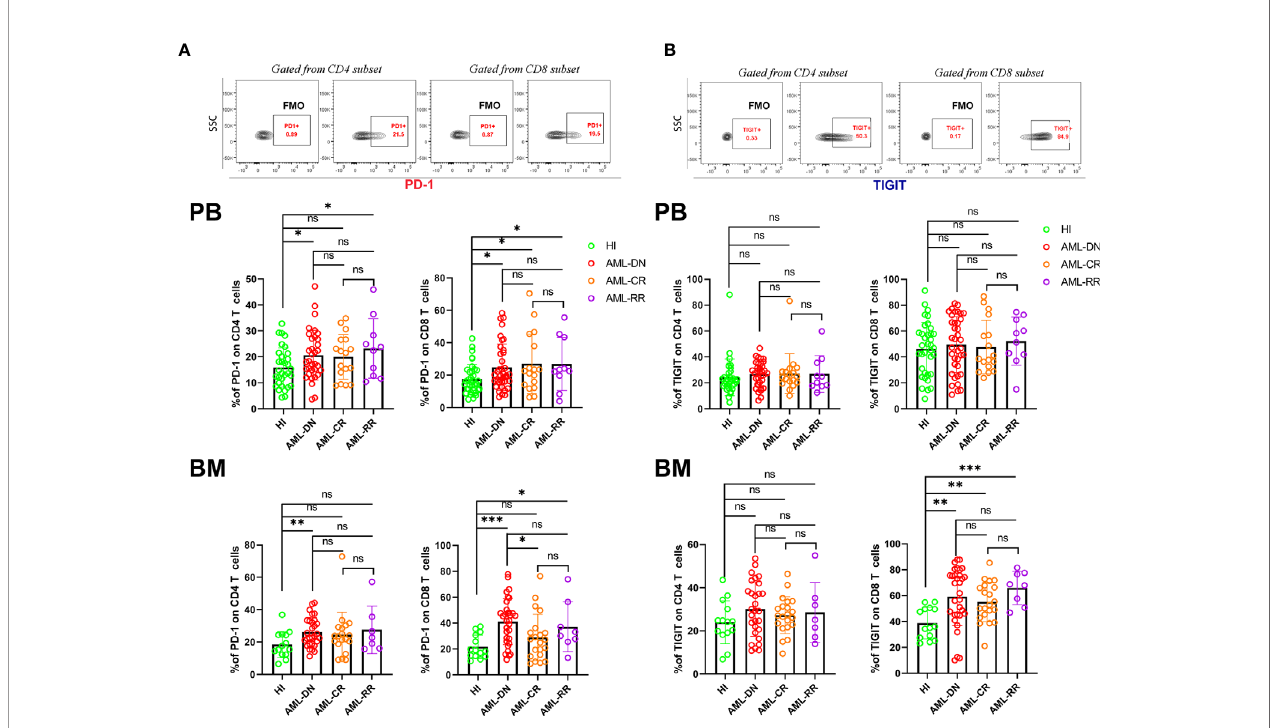
FIGURE 1 | T cells from the PB and BM of DN AML and R/R AML patients generally have high expression of PD-1, and BM CD8 + T cells from DN, CR, and R/R patients have increased TIGIT expression. (A) The top fi gure shows the gating strategy for PD-1 in the CD4 + and CD8 + populations by fl ow cytometry. The frequency of PD-1 by subset in the PB of HIs (CD4, n=33; CD8, n=36) and patients in the AML-DN (CD4, n=34; CD8, n=38), AML-CR (n=17), and AML-R/R (n=10) cohorts ( Upper ); The frequency of PD-1 by subset in the BM of HIs (n=14), and patients in the AML-DN (CD4, n=29; CD8, n=32), AML-CR (n=21), and AML-R/R (CD4, n=7; CD8, n=8) cohorts ( Lower ). The PD-1 expression frequency generally increased in T cells from DN and R/R patients. (B) The top fi gure shows the gating strategy for TIGIT in the CD4 + and CD8 + populations by fl ow cytometry. The frequency of TIGIT by subset in the PB ( Upper ) and BM of HIs, and patients in the AML-DN, AML-CR, and AML-R/R cohorts ( Lower ); The TIGIT expression frequency increased in BM CD8 + T cells from DN, CR, and R/R patients compared with HIs. The p values shown are from independent t-tests between groups. * p < 0.05, ** p < 0.01, *** p < 0.001, ns denotes not signi fi